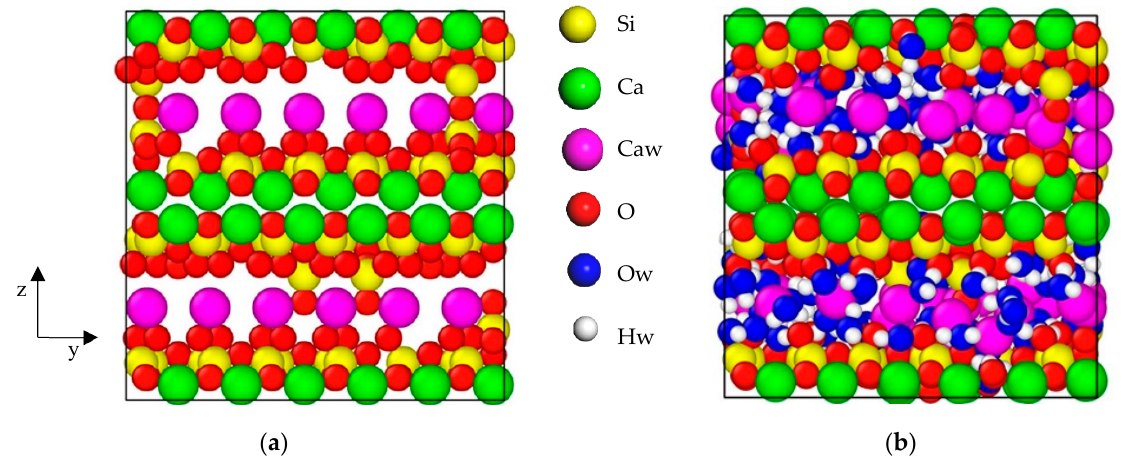
Figure 1. ( a ) Dry C–S–H ( b ) saturated C–S–H . Simulation box size : ( a )a = 2.23 nm, b = 2.22 nm, c = 2.28 nm; ( b ) a = 2.20 nm, b = 2.18 nm, c = 2.24 nm. Yellow ball, green ball, pink ball, red ball, blue ball and white ball represent the silicon atom (Si), layered calcium atom (Ca), interlayer calcium (Caw), oxygen atom (O) in the silicate chain, oxygen atom (Ow) in water and hydrogen atom (Hw) in water respectively.